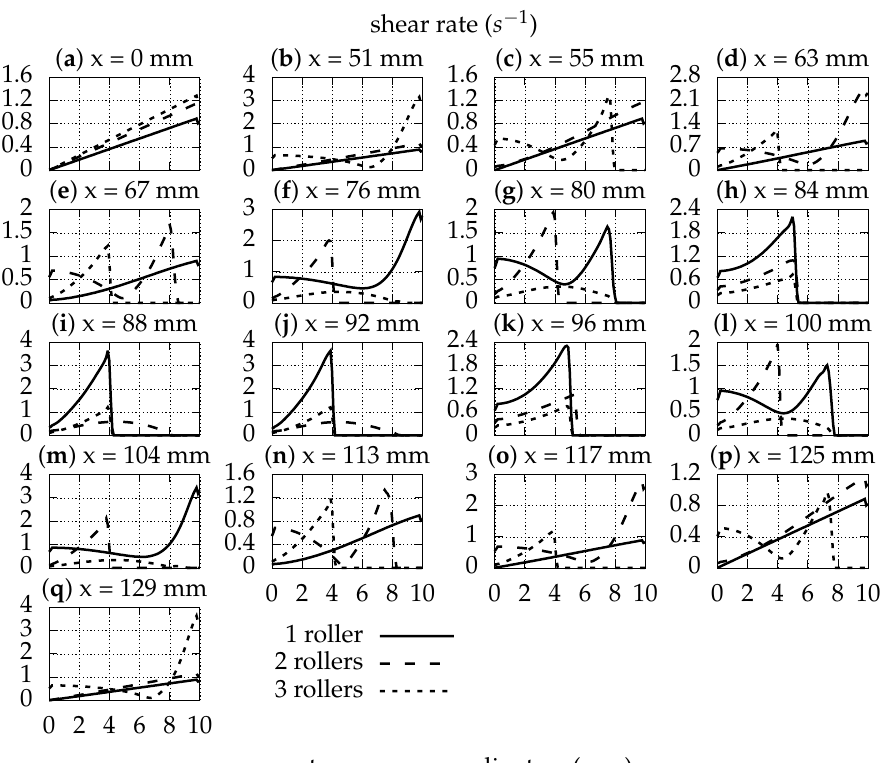
Figure 19. Shear rate profiles at successive longitudinal positions x ( a – q ) for various numbers of rollers. The roller speed is c = 5 mm/s, the relative occlusion is RO = 0.6 and the Bird–Carreau power index is n = 1.